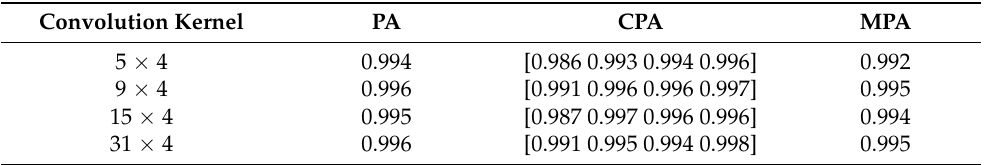
Table 5. The experimental results under different convolution kernel sizes.